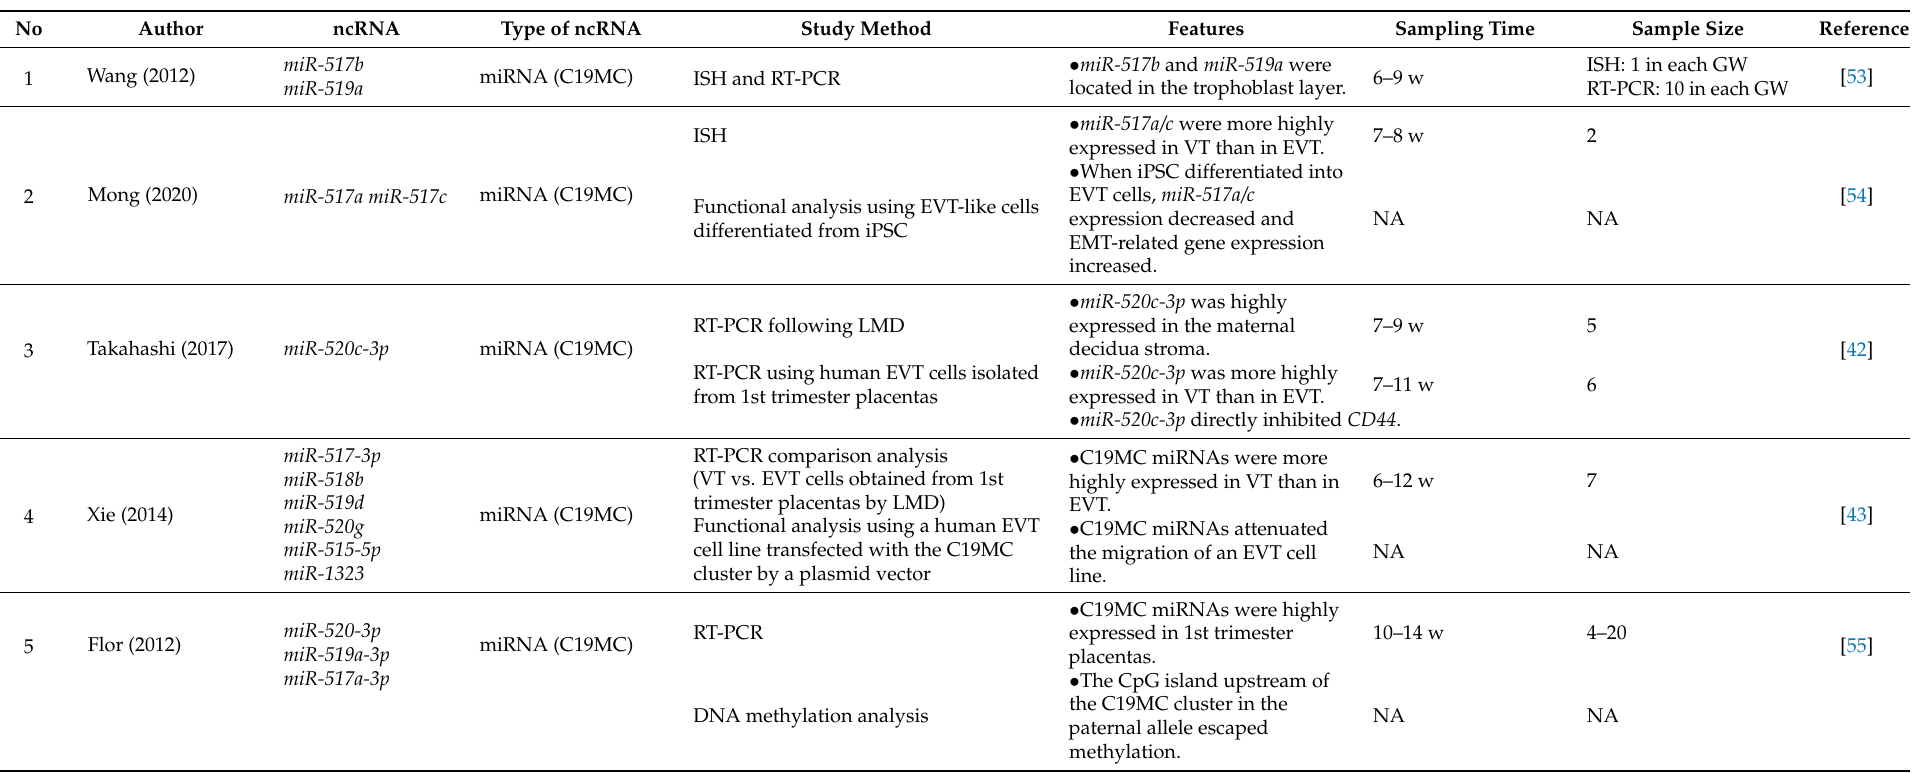
Table 2. Highly expressed non-coding RNAs in the human early placenta (Validation of the expression levels of non-coding RNAs using 1st trimester